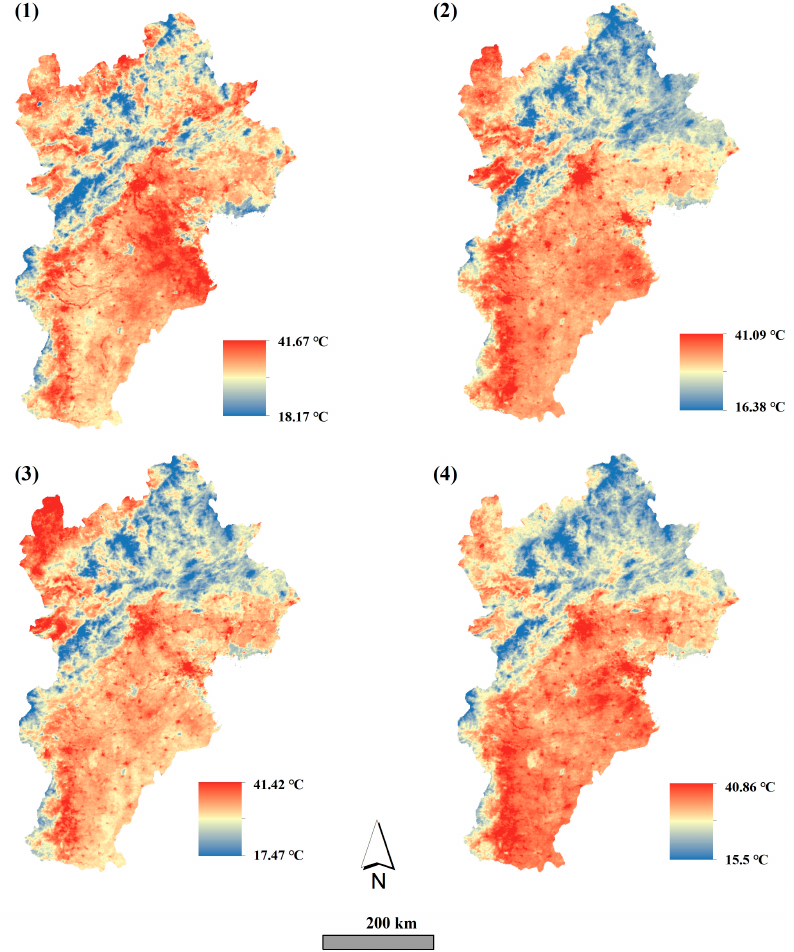
Figure 3. The land surface temperature (LST) for the BTH region in the summer seasons of ( 1 ) 2000, ( 2 ) 2005, ( 3 ) 2010, and ( 4 )